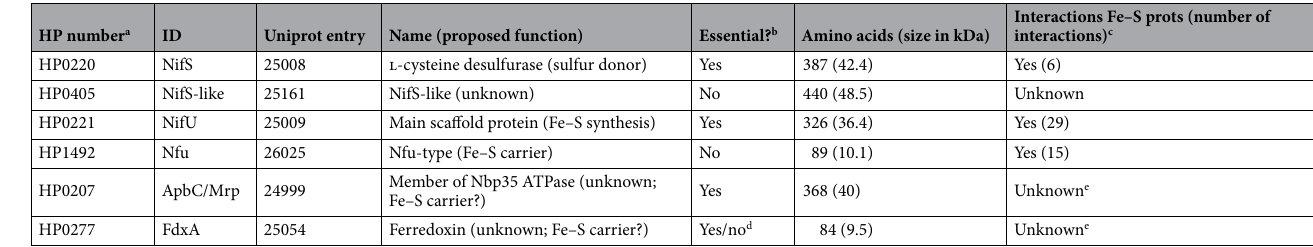
Table 1. Main components of the H. pylori NIF system. a HP number refers to strain 26695 26 . b Based on chromosomal mutagenesis attempts (as found in this study, or as reported by 28,29,34 ). c As reported by 29 . d H. pylori strain specific (as found in this study, and as reported by 34 ). e Before the current